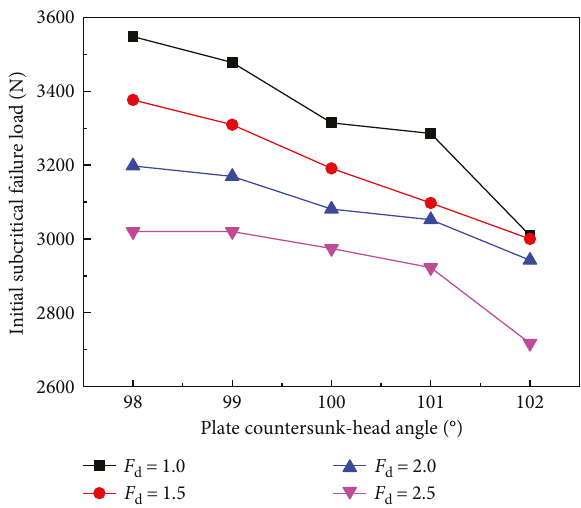
Figure 14: In fl uence of deviation of the countersunk on the initial subcritical failure load under di ff erent delamination factors. Figure 15: E ff ect of T